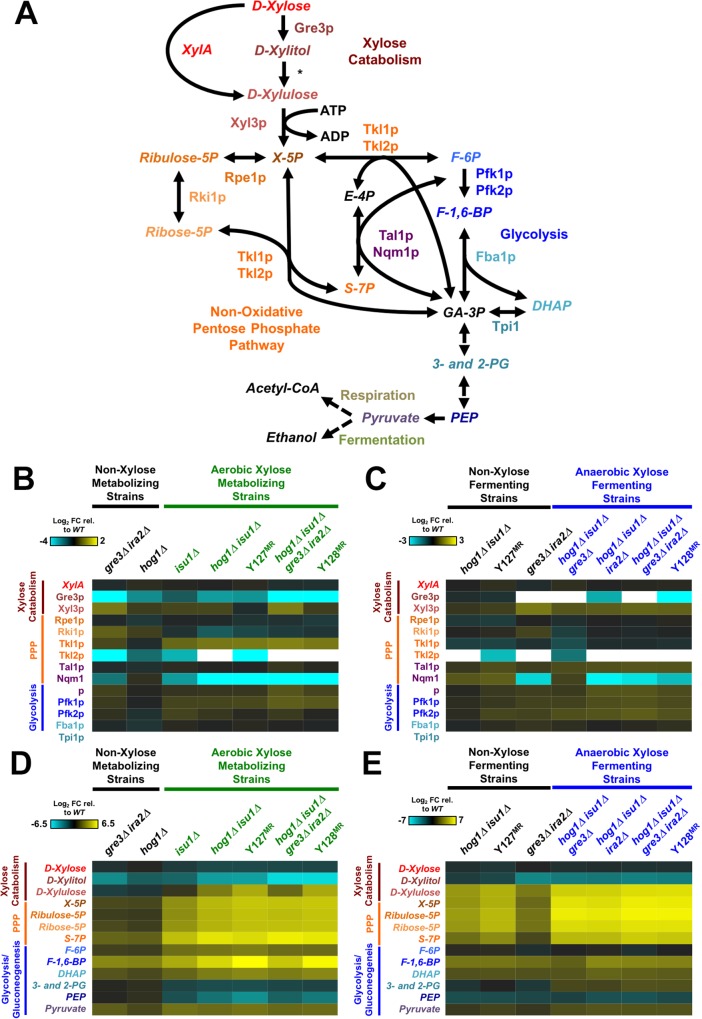
Xylose-metabolizing strains have altered pentose phosphate pathways.Heat maps display intracellular concentrations of proteins and metabolites from xylose metabolism, pentose phosphate pathway and glycolysis (A) from engineered and evolved strains relative to Y22-3MR. Colors correspond to average Log2 fold change values from strains cultured under aerobic (B and D) or anaerobic (C and E) conditions in YPX medium from three biological replicates. White boxes indicate strains for which no corresponding peptides were detected. The asterisk (*) in (A) denotes an enzyme activity that is absent in the Y22-3MR strain. Abbreviations: X-5P, xylulose-5-phosphate; S-7P, sedoheptulose-7-phosphate; F-6P, fructose-6-phosphate; F-1,6-BP, fructose-1,6-bisphosphate; DHAP, dihydroxyacetone-phosphate; 3- and 2-PG, 3- and 2-phosphoglycerates; PEP, phosphoenolpyruvate.